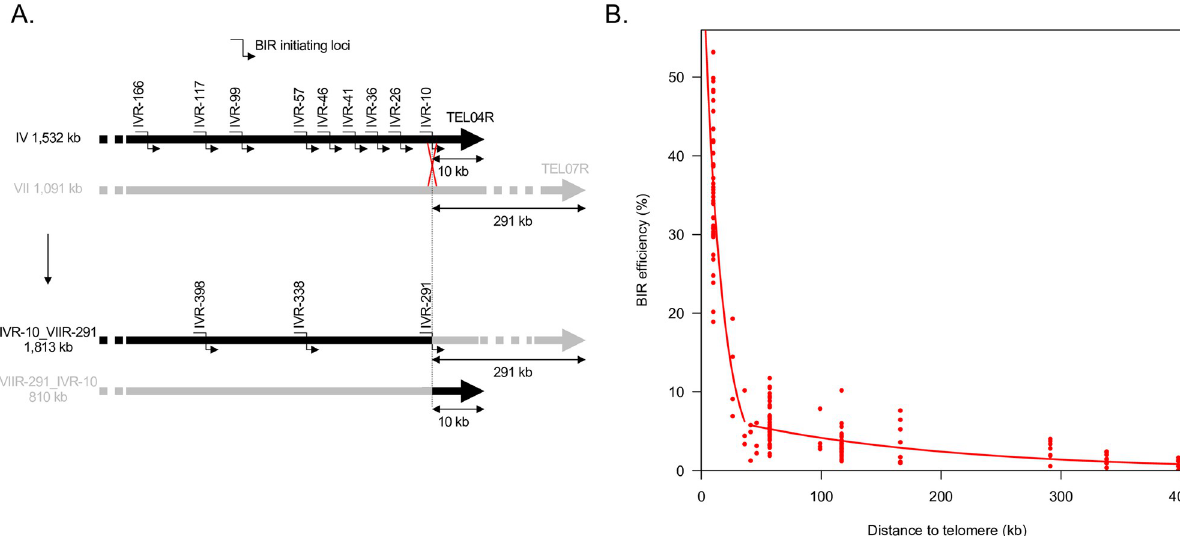
Fig 2. A . Diagram representing the twelve BIR initiating loci used to generate Fig 2B (S3 Table). Top: wild type strains with nine BIR initiating loci on the right arm of chromosome IV. Bottom: translocated strains with three BIR initiating loci IVR-398, IVR-338 and IVR-291 corresponding to the IVR- 117, IVR-57 and IVR-10, respectively, from the parental non-translocated strains. B . BIR efficiency modelled as a combination of two exponential functions of the length of DNA to synthesize. BIR efficiency is expressed as the ratio between the number of transformants from the linearized chromosome fragmentation vector and the number of transformants from the circular chromosome fragmentation vector containing an autonomous replicating sequence (ARS). The two red curves represent exponential law fits. See main text for details.